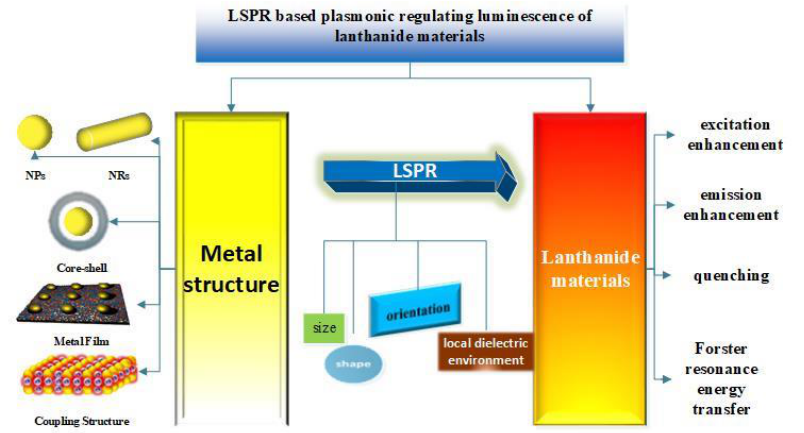
Figure 1. Table of contents(TOC) drawing of localized surface plasmon resonance (LSPR)-based plasmonic regulating luminescence of lanthanide materials. Image of metal film and coupling structure, from Reference [14] and Reference [12].